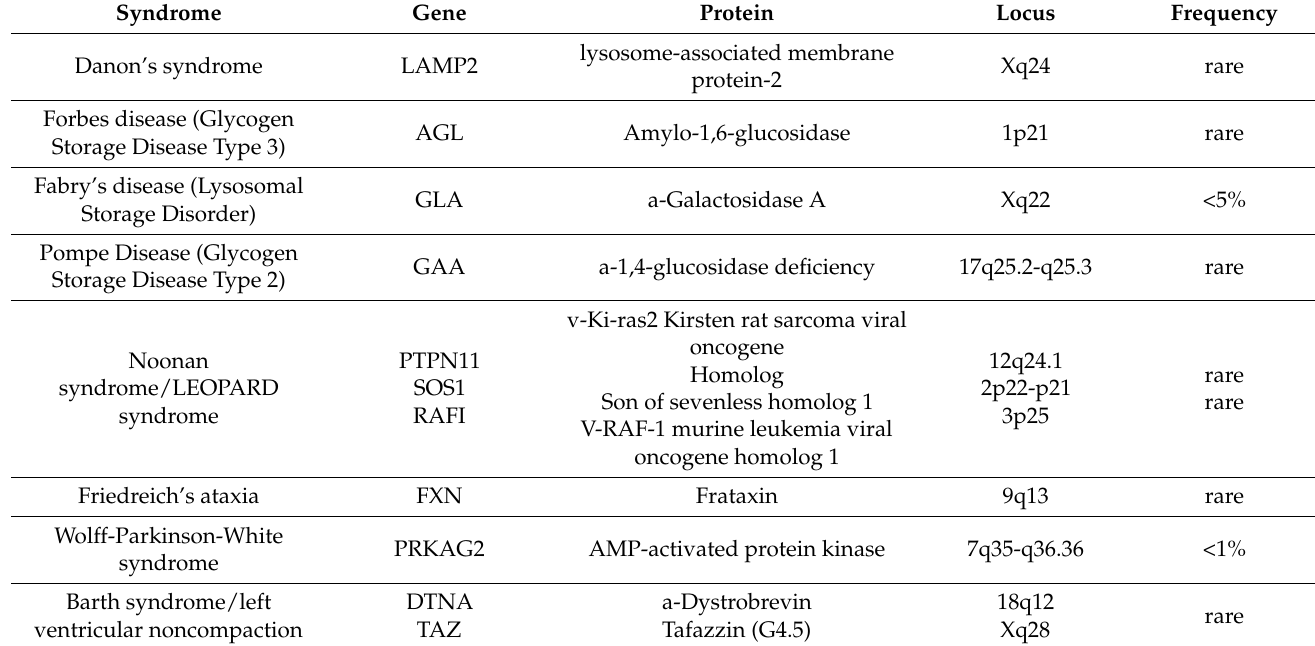
Table 2. Phenocopies of hypertrophic